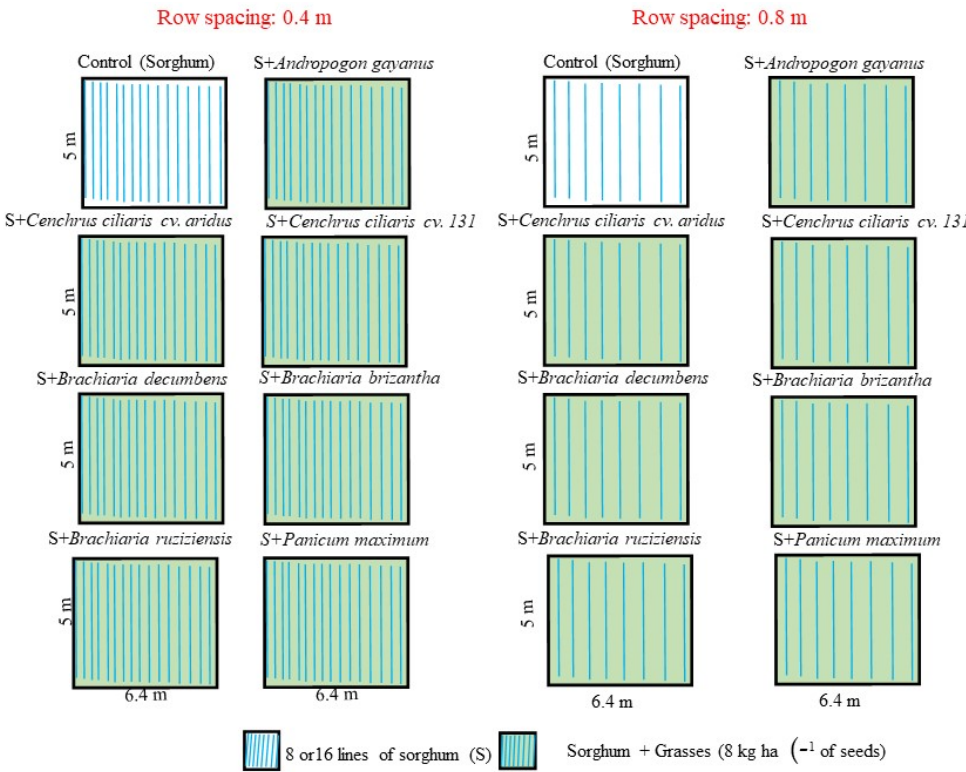
Figure 2. Experimental design with sorghum and grass intercrop combinations ( Andropogon gayanus —AG; Cenchrus ciliaris cv. aridus—CCA; Cenchrus ciliaris cv. 131—CC; Brachiaria decumbens —BD; Brachiaria brizantha —BB; Brachiaria ruziziensis —BR; Panicum maximum Jacq—PM) with two planting ‐ row spacings (0.4 or 0.8 m). Grass was planted in the inter ‐ row of sorghum.